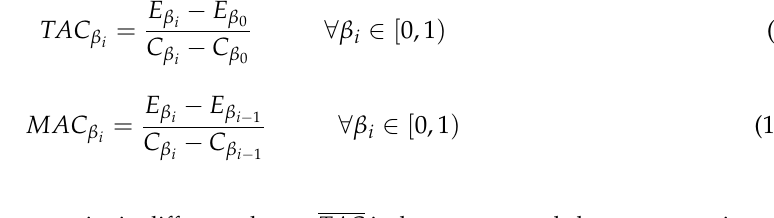
Table 2. Cost of abatement strategies in different phases. TAC is the average total abatement cost in each phase and MAC is the average marginal abatement cost in each